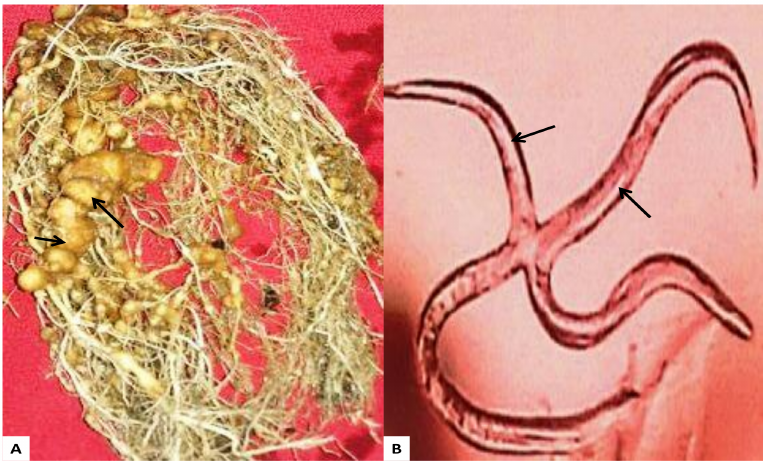
Figure 7. ( A ) Infected root caused by nematode M. Incognita ( B ) M. incognita